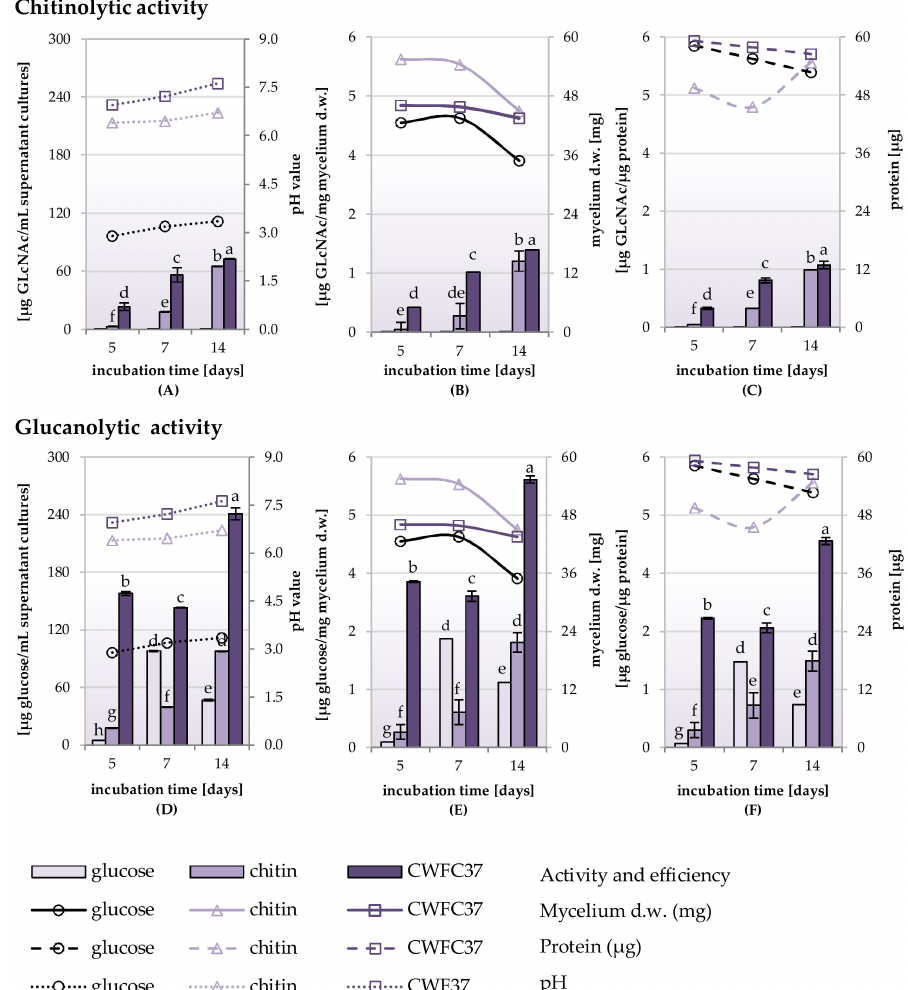
Figure 6. The chitinolytic ( A , B , C ) and glucanolytic activity ( D , E , F ) of the Trichoderma DEMTkZ3A0 strain on three carbon sources: Glucose, chitin, and lyophilized cell wall of the pathogenic F. culmorum strain (CWFC37) after 5, 7, and 14 days of incubation based on released N -acetyl- d -glucosamine ( µ g GLcNAc / mL ( A ) or µ g GLcNAc / mg mycelium ( B ) or GLcNAc / µ g protein ( C ) for chitinolytic activity, and glucose ( µ g glucose / min / mL ( D ) or µ g glucose / mg mycelium ( E ), µ g glucose / µ g protein / ( F ) for glucanolytic activity) from the appropriate substrate in 1 min. Bars represented standard deviations (SD). Values followed by di ff erent letters are significantly di ff erent (one-way analysis of variance (ANOVA) followed by a Tukey’s post hoc test with the significance evaluated at p <